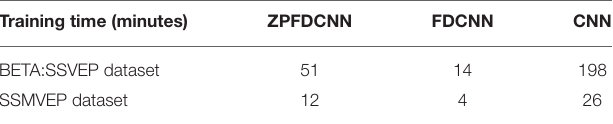
TABLE 4 | Comparison of training once time of the ZPFDCNN method, the FDCNN method, and the CNN method in BETA:SSVEP dataset (under the time window of 1.0 s) and SSMVEP dataset (under the time window of 0.7 s).